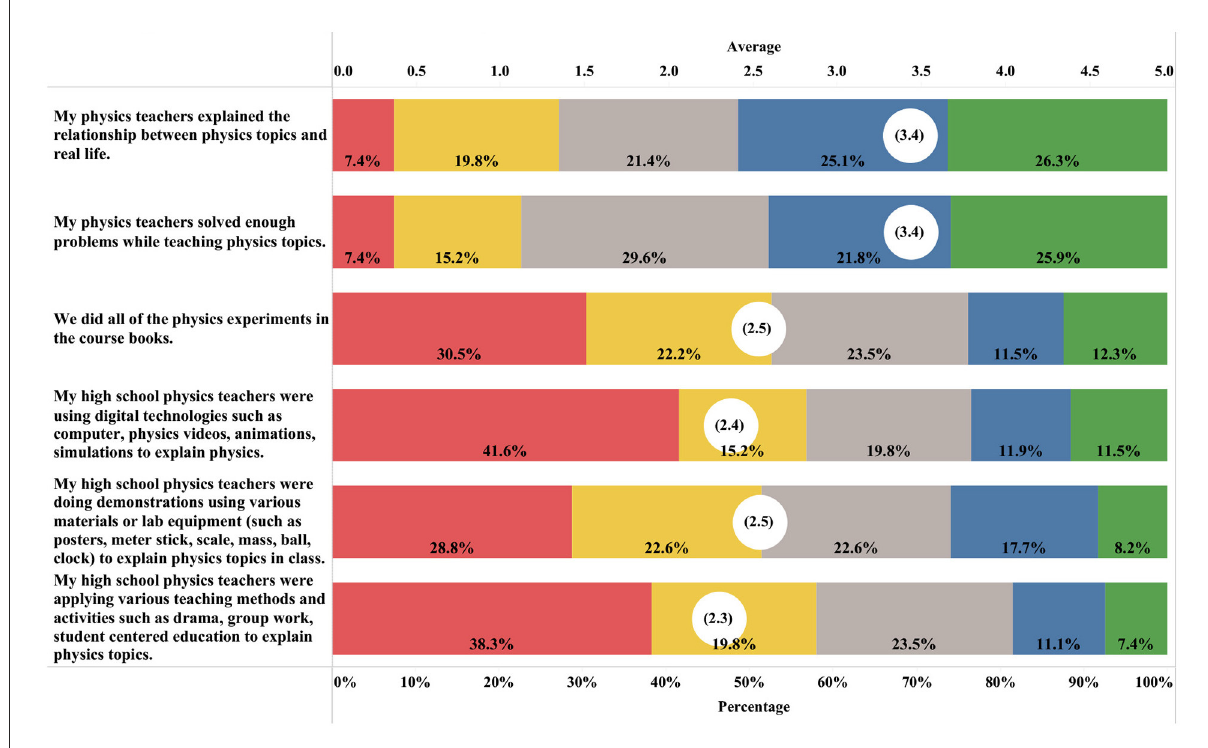
FIGURE2 Distribution based on item related to physics course and agreed level.